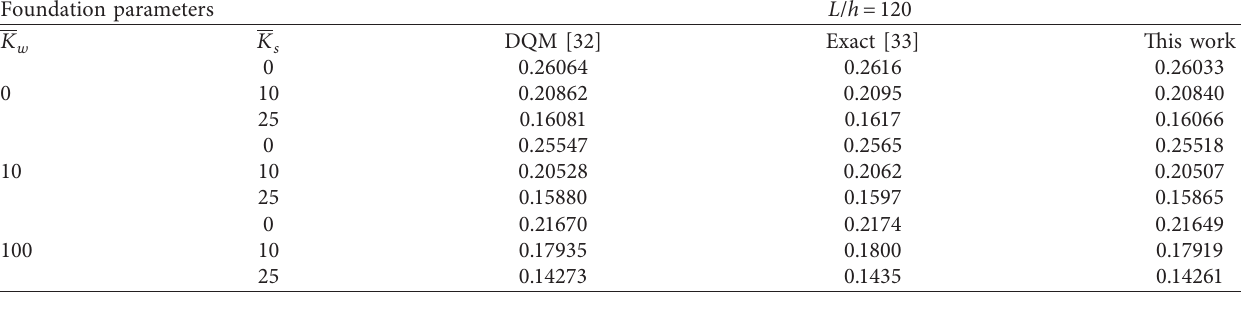
Table 4: Comparative nondimensional maximum deflections w � EI / P on the Winkler–Pasternak two-parameter elastic foundation,